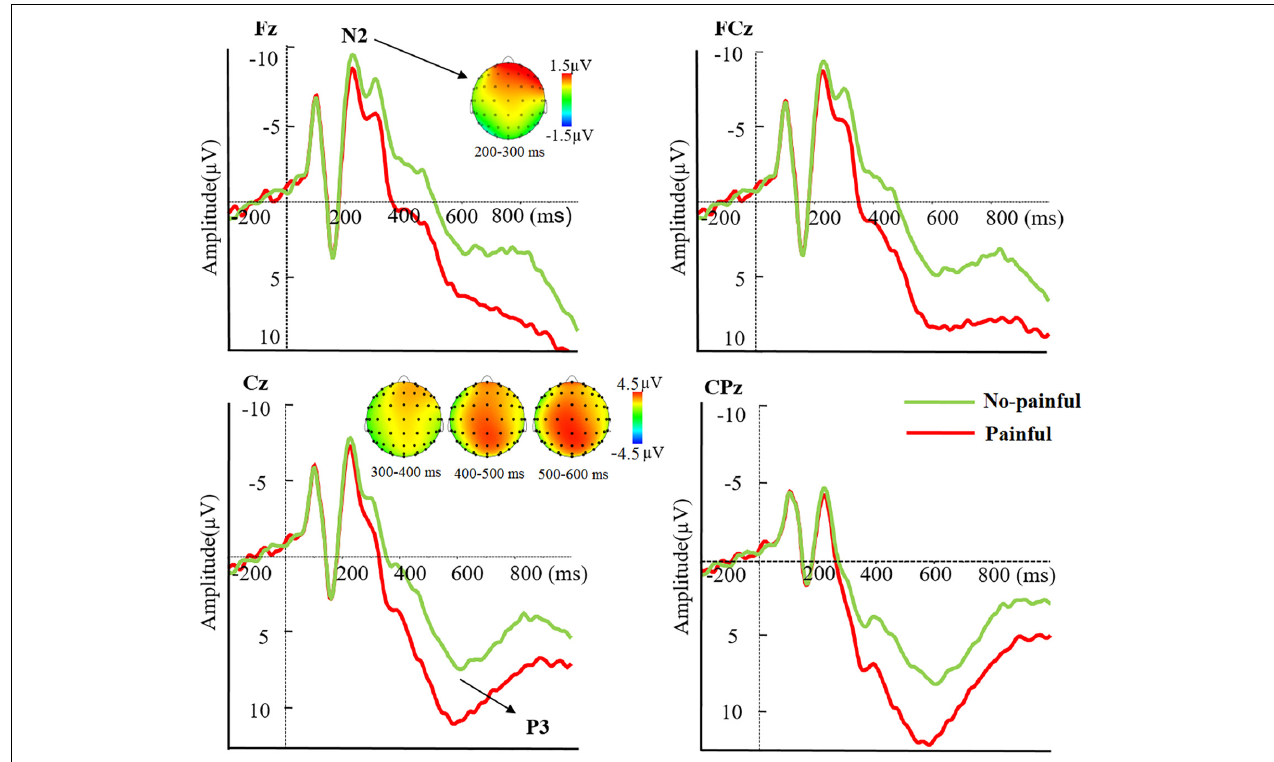
FIGURE 3 | Averaged ERPs at Fz, FCz, Cz, and CPz to painful (red lines) and no-painful (green lines) stimuli, and topographical maps of voltage amplitudes for painful minus no-painful stimuli difference at the N2 and P3